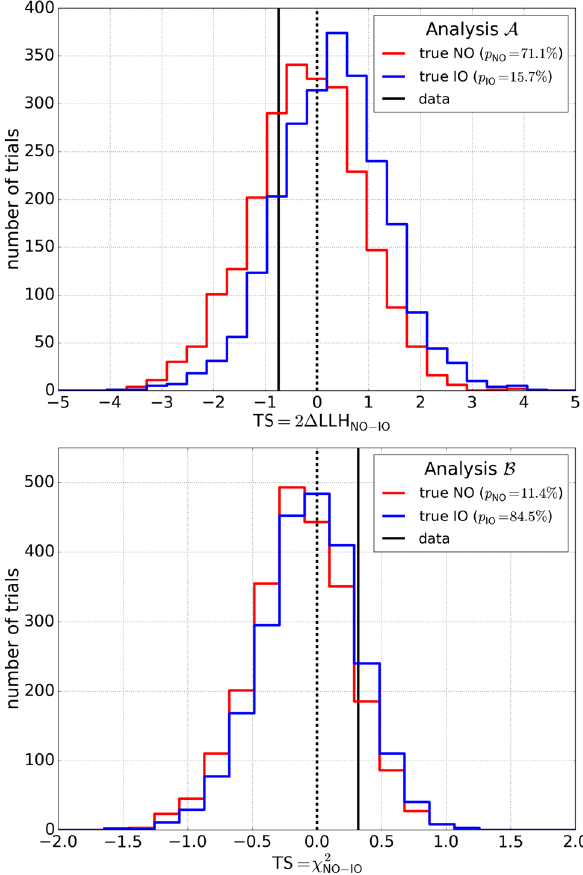
Fig. 10 Distribution of the TS from PTs, generated with the best-fit systematic parameters η NO and η IO from Table 2 for Analysis A (top) andAnalysis B (bottom).Theredandbluedistributionsareobtainedfor the NO and IO hypotheses, respectively, while the black, solid vertical line shows the observed value in data, giving the p -values for the NO and IO hypotheses stated in the legends